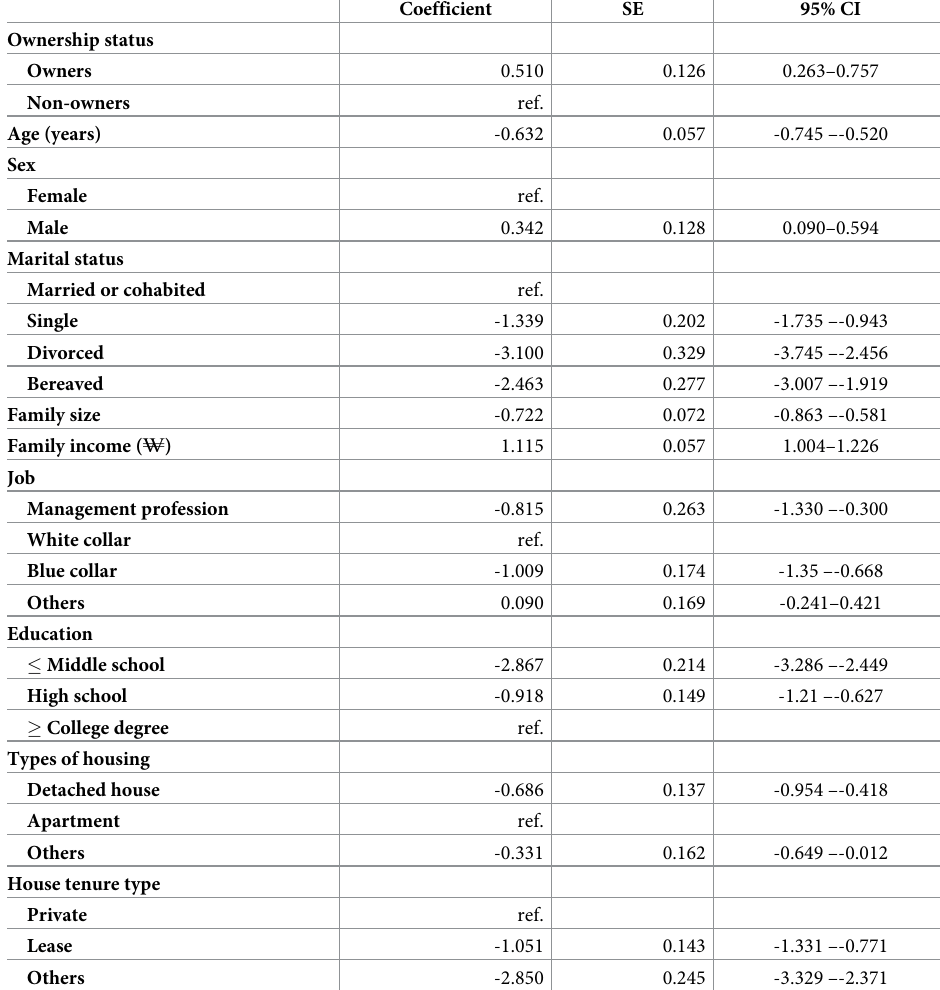
Table 3. Multiple linear regression on overall life satisfaction using propensity score